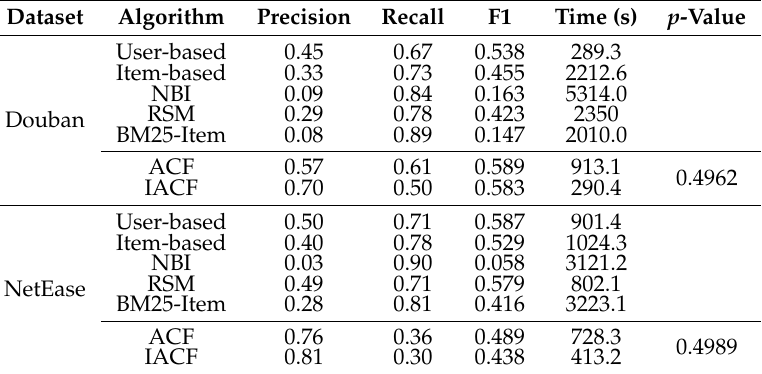
Table 3. Ranking results